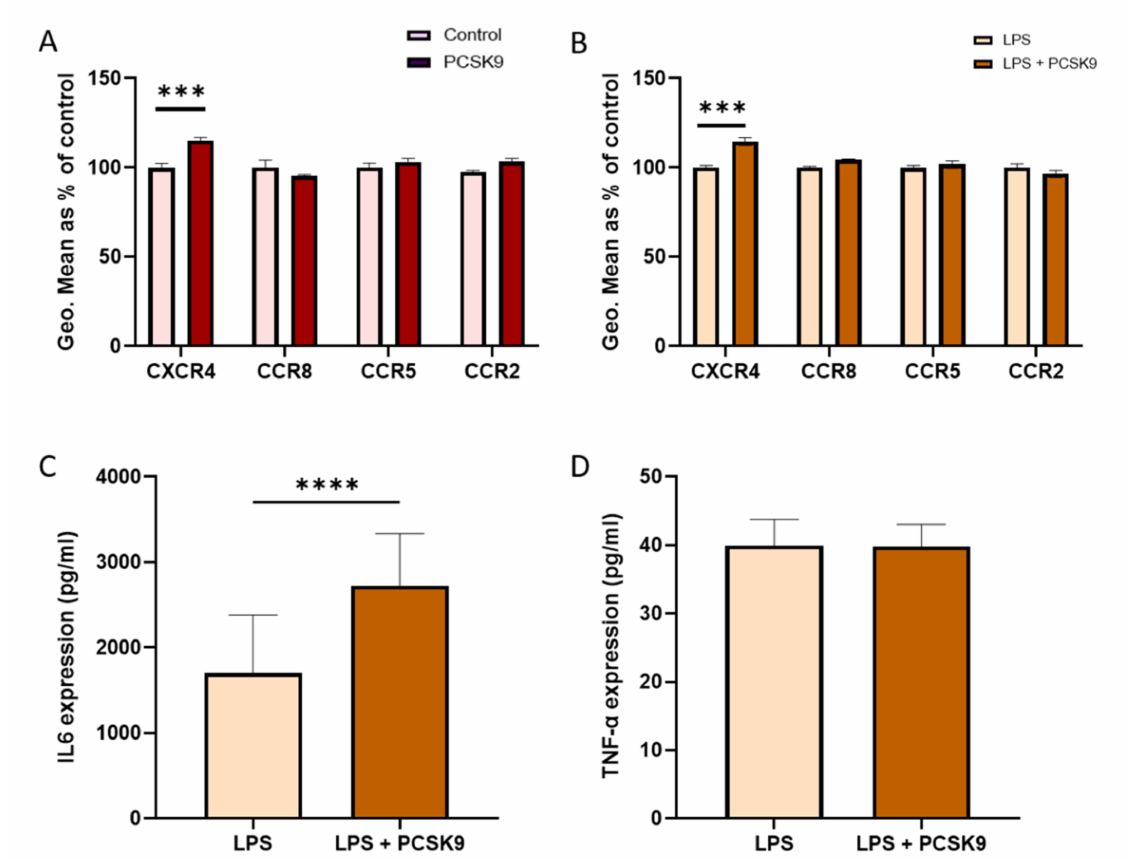
Figure 7. PCSK9 marginally affects the expression of chemokine receptors in human coronary artery endothelial cells while considerably increasing the secretion of IL6. The expression of chemokine receptors CXCR4, CCR8, CCR5, and CCR2 were measured using flow cytometry and represented using geometric mean (Geo.Mean) in HCAECs ( n = 3–4 replicates) with and without PCSK9 ( A ) and when exposed to an inflammatory environment with LPS ( B ). Inflammatory cytokines IL6 ( C ) and TNF- α ( D ) expressions measured in the supernatant of the cell culture with and without PCSK9 in an inflammatory environment ( n = 3–4 replicates). Bar graphs are representation of mean ± SEM. *** p < 0.001, **** p < 0.0001. 2-way ANOVA was used for ( A , B ), and the Mann–Whitney test was used for ( C , D ) to calculate the statistical